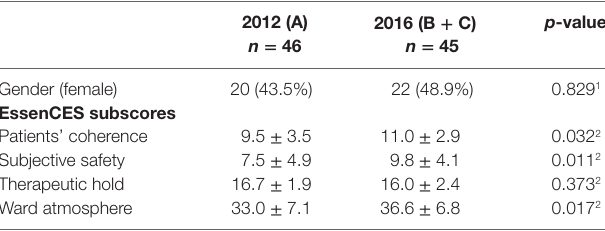
taBle 1 | Overall effects of anti-aggression and de-escalation (ADE)